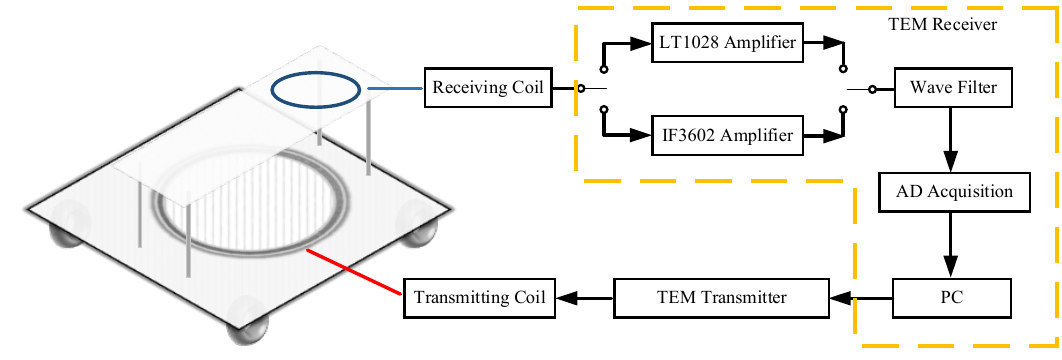
Figure 13. Schematic diagram of laboratory simulation comparison test.